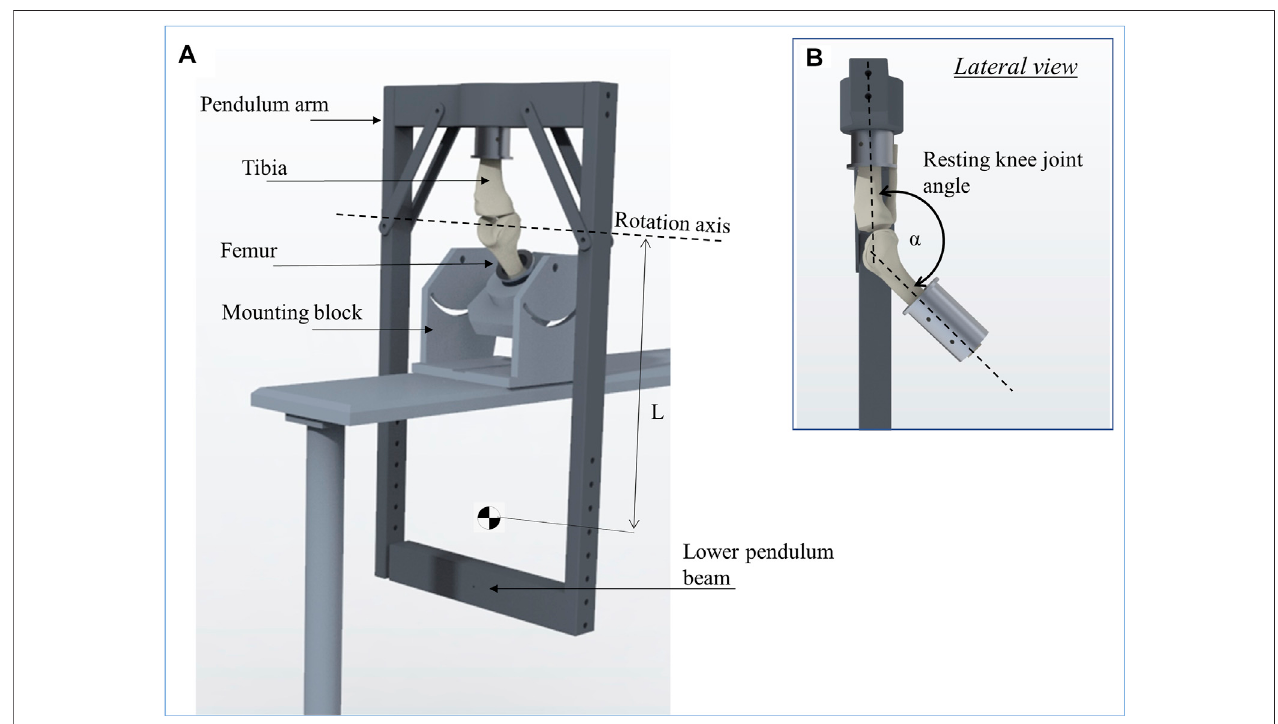
FIGURE 3 | Schematic representation of the passive pendulum friction testing device that was used (A) . The femur is fi xed in an inclined mounting block and the pendulumarmisattachedtothetibia,wherebytherestingkneejointanglebetweenthetibiaandfemur( α )wassetto140 ° toachieveaphysiologicaljointloading (B) .The rotationaxisofthependulummotionisdescribedbytherotationaxisofthekneejointin fl exion-extension.Thelengthofthependulum(L)isthedistancefromitscenterof mass to the rotation axis.